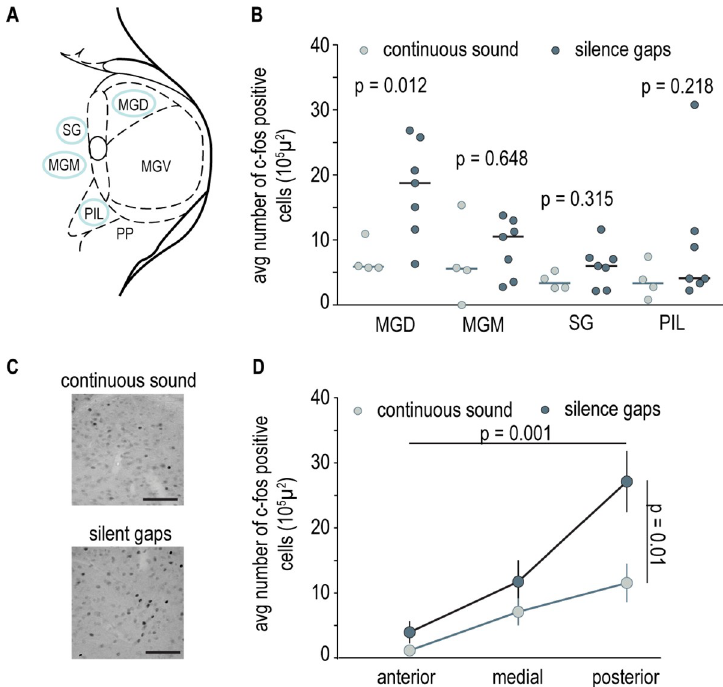
Fig 2. Differential activity in the MGD triggered by the cessation of movement-evoked sound. (A) Schematics of the MGB and its subnuclei. Regions circled in blue are part of both the mono- and polysynaptic pathway to the LA. (B) Average number of c-fos -positive cells in the MGD and MGM, the SG, and the PIL of individual rats from the continuous sound (light gray n = 4) and silence gaps (dark gray n = 7) group. The horizontal bar represents the median value, and Wilcoxon rank sum test was used for comparisons (MGD continuous sound = 5.87, silence gaps = 18.7, rank sum = 11; MGM continuous sound = 5.54, silence gaps = 10.50, rank sum = 21; SG continuous sound = 3.36, silence gaps = 5.95, rank sum = 18; PIL continuous sound = 3.33, silence gaps = 4.07, rank sum = 17) (S1 Data, Sheet Fig 2). (C) Representative pictures of c -fos -labeled cells in MGD. Scale bar 100 μ m. (D) Line graph showing average number of c-fos -labeled cells in the MGD along the anterior-posterior axis for continuous sound and silence groups. Vertical bars represent ± SEM ( n -way ANOVA main effect repeated measures AP axis p = 0.001, F = 12.69; silence versus continuous sound effect p = 0.01, F = 7.71) (S1 Data, Sheet Fig 2). LA, lateral amygdala; MGB, medial geniculate body; MGD, dorsal division of the MGB; MGM, medial division of the MGB; MGV, ventral division of the MGB; PIL, posterior intralaminar thalamic nucleus; PP, peripeduncular nucleus; SG, suprageniculate nucleus.